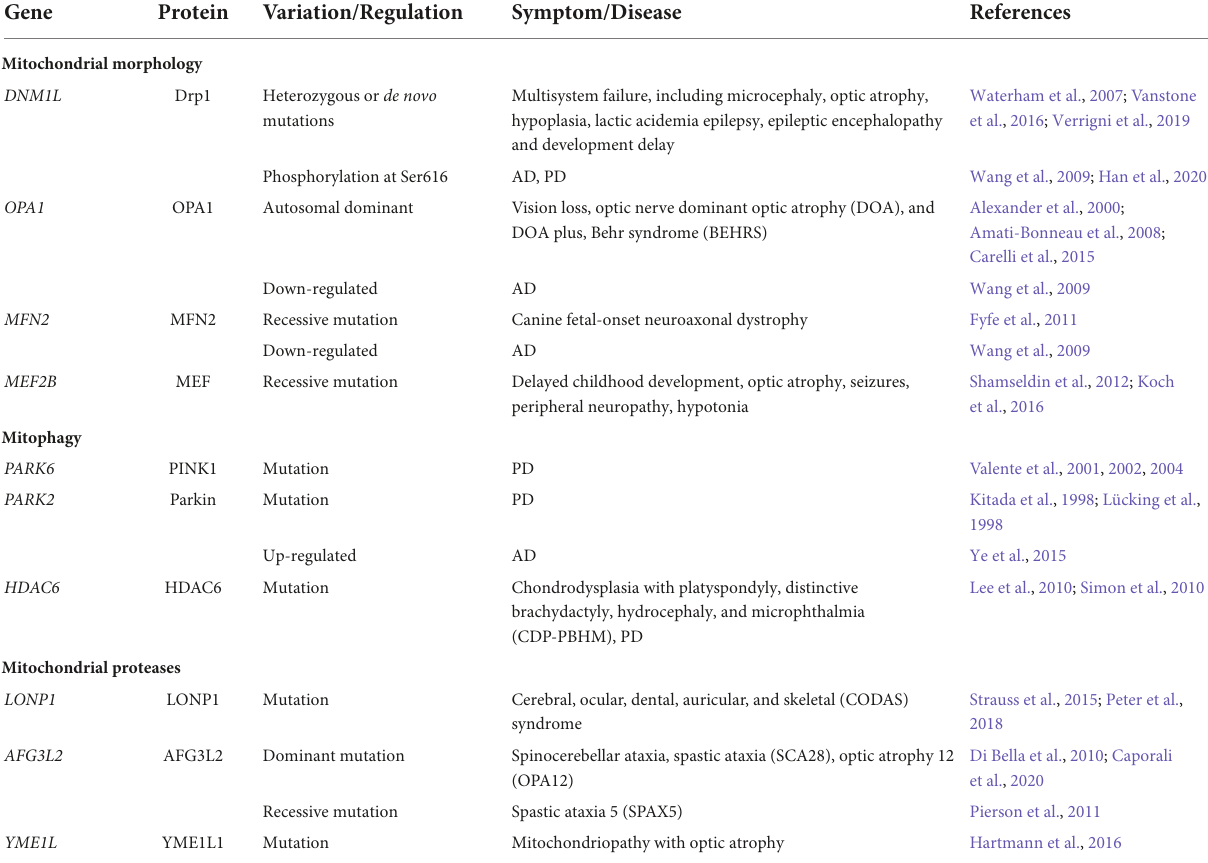
TABLE 1 Mitochondrial quality control gene abnormality-related